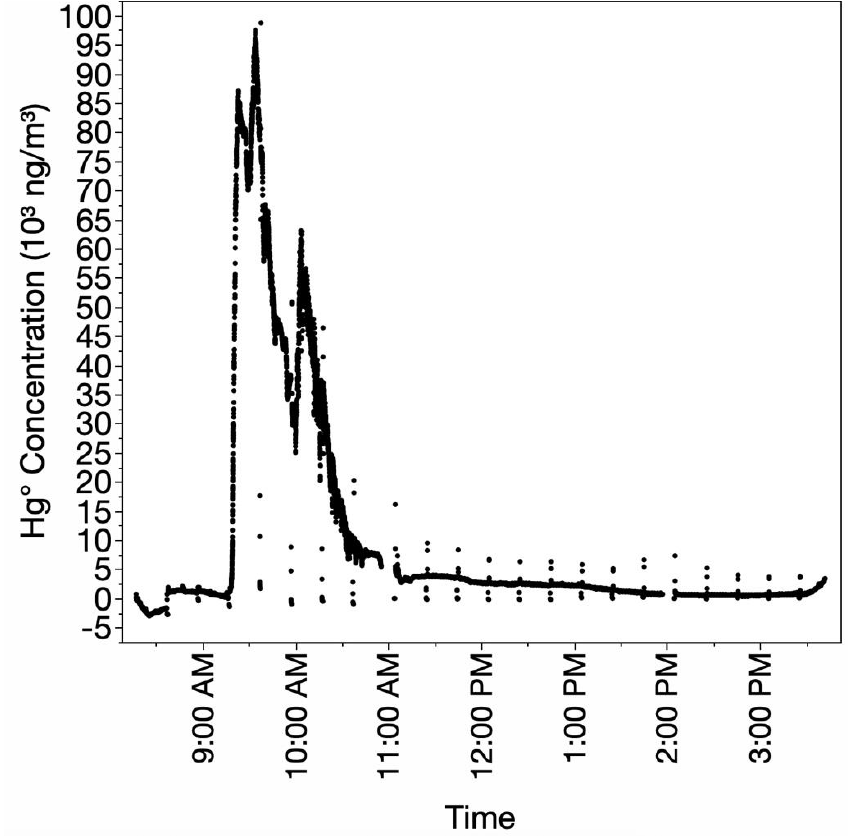
Figure 4. Hg 0 concentrations recorded during the smelting of sponge gold in the Guyana Gold Board (GGB) processing facility in Bartica, Guyana.